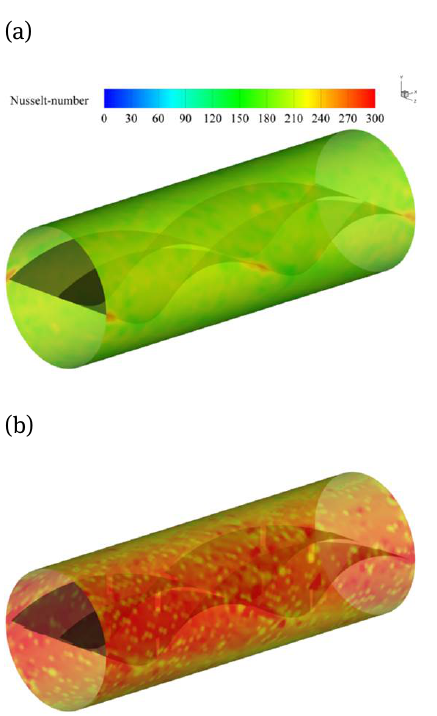
Figure 7: Distribution of local Nusselt number around the tube: (a) dual twisted tapes (DTs); (b) peripherally-cut dual twisted tapes (PDTs: l / y = 0.5) .